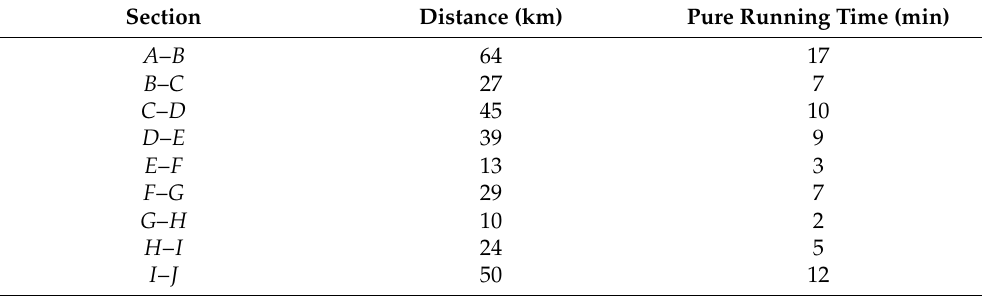
Table 9. Distance and pure running time in each section.